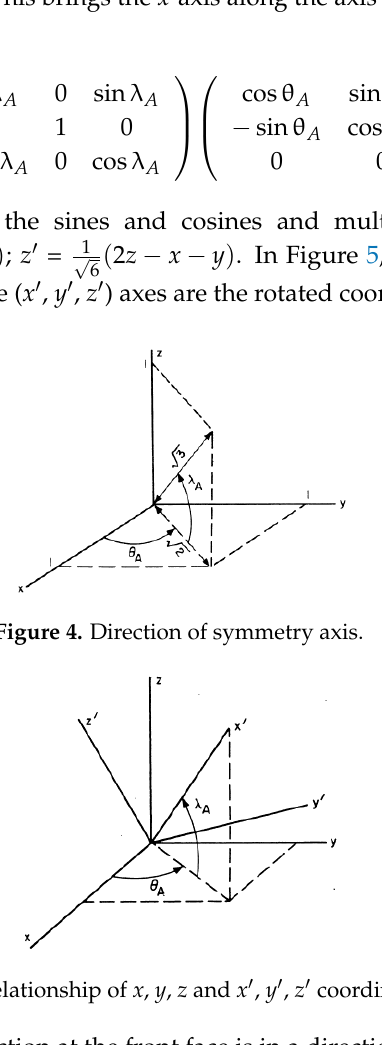
Figure 5. Relationship of x, y, z and x’, y’, z’ coordinate axes.